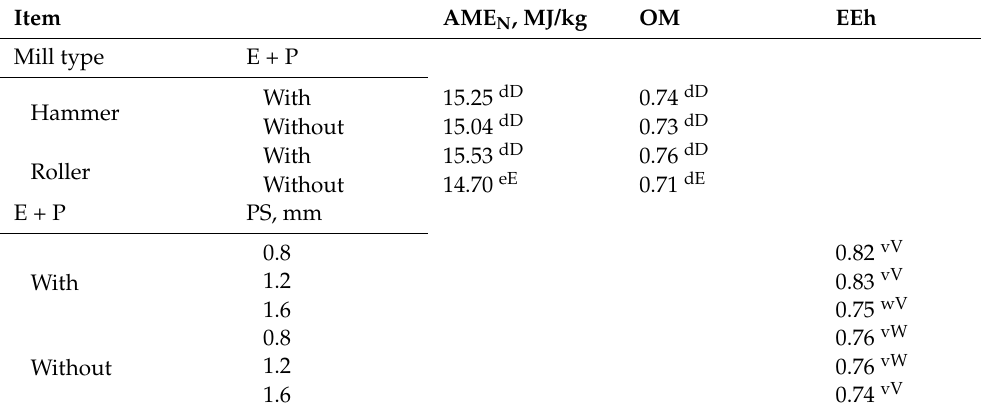
Table 11. Breakdown of the significant interactions as presented in Table